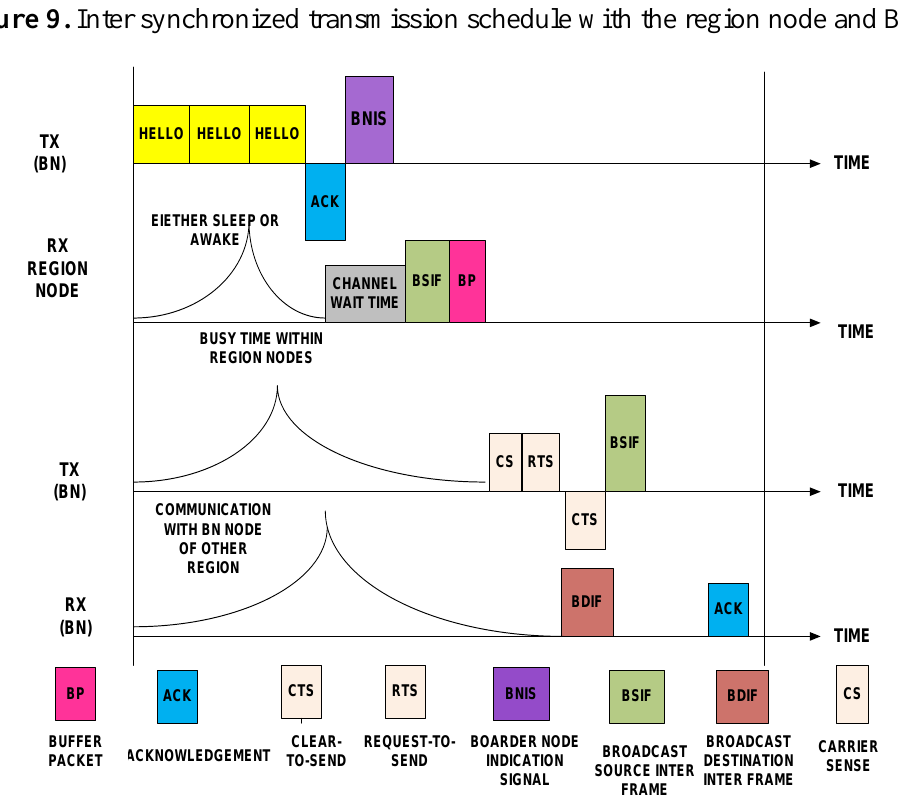
Figure 9. Inter synchronized transmission schedule with the region node and